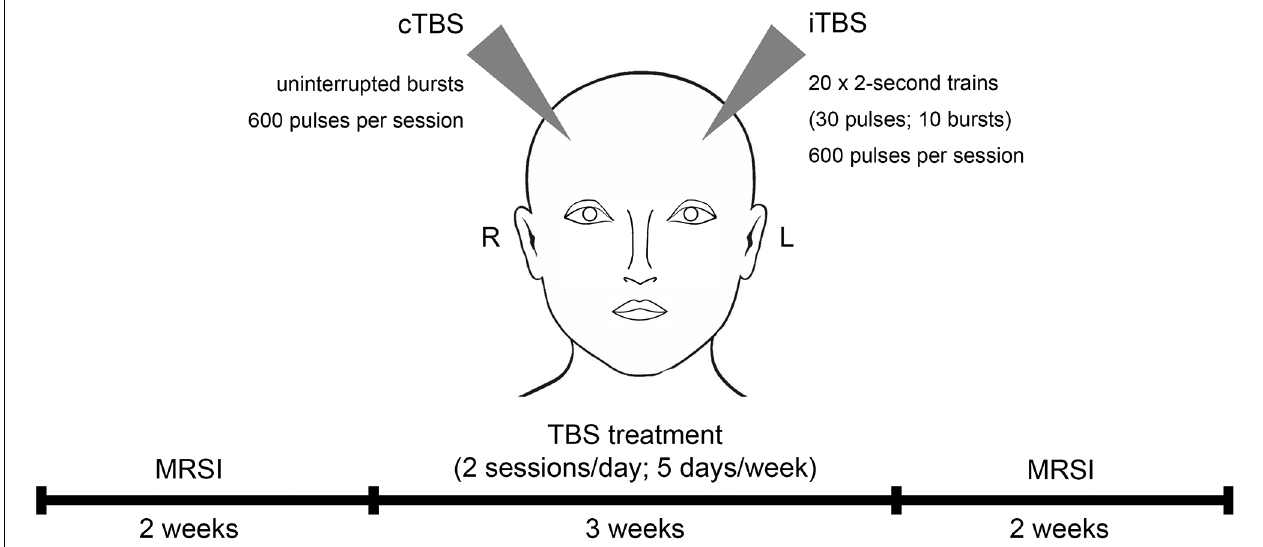
FIGURE 1 | Study design and treatment regime. Study subjects received theta burst stimulation (TBS) over 3 weeks including two stimulations a day for 5 days per week. TBS sessions comprised intermittent TBS (iTBS) to the left and continuous TBS (cTBS) to the right dorsolateral prefrontal cortex. Magnetic resonance spectroscopy imaging (MRSI) measurements were conducted within 2 weeks before and after the treatment period.